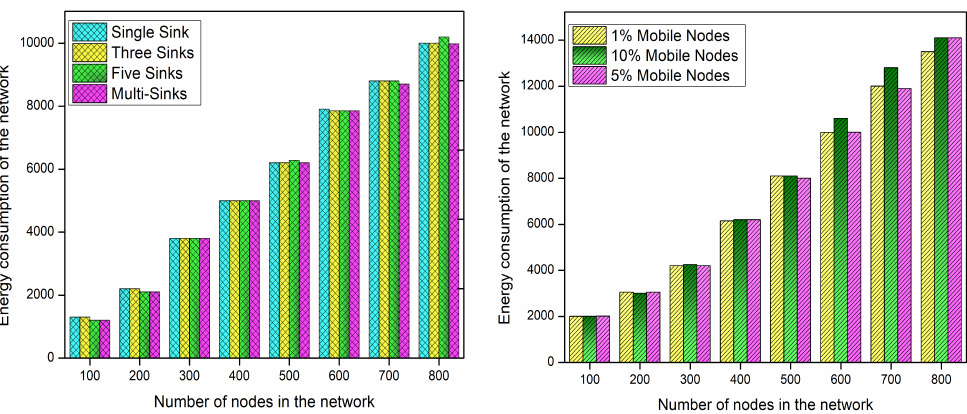
Figure 6. Performance evaluation of RTC based on total network energy